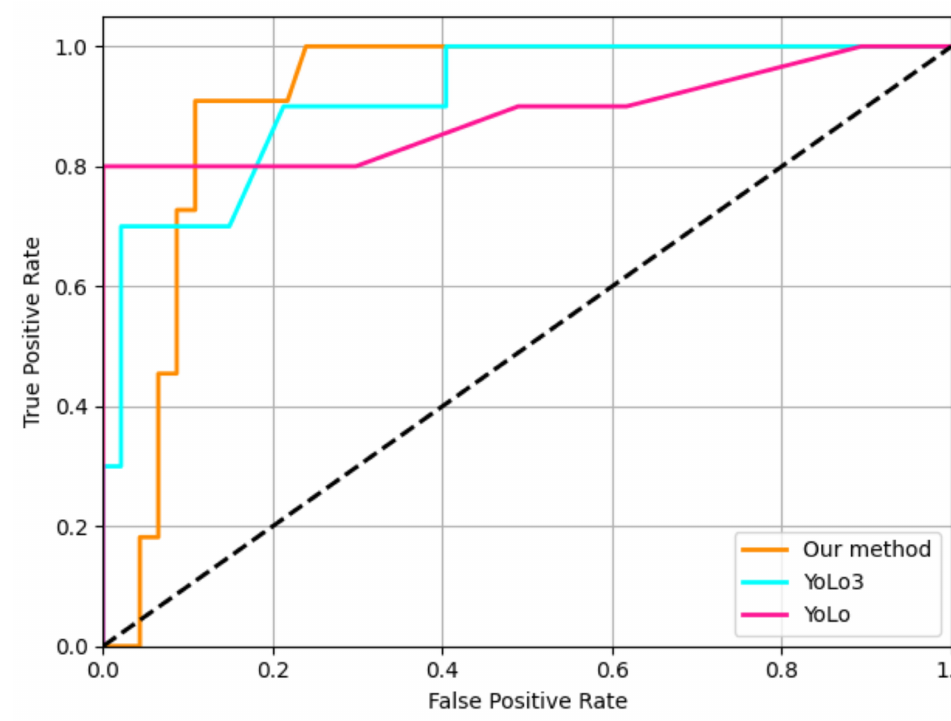
Figure 7. ROC curves of YOLO, YOLOv3, and the proposed framework.